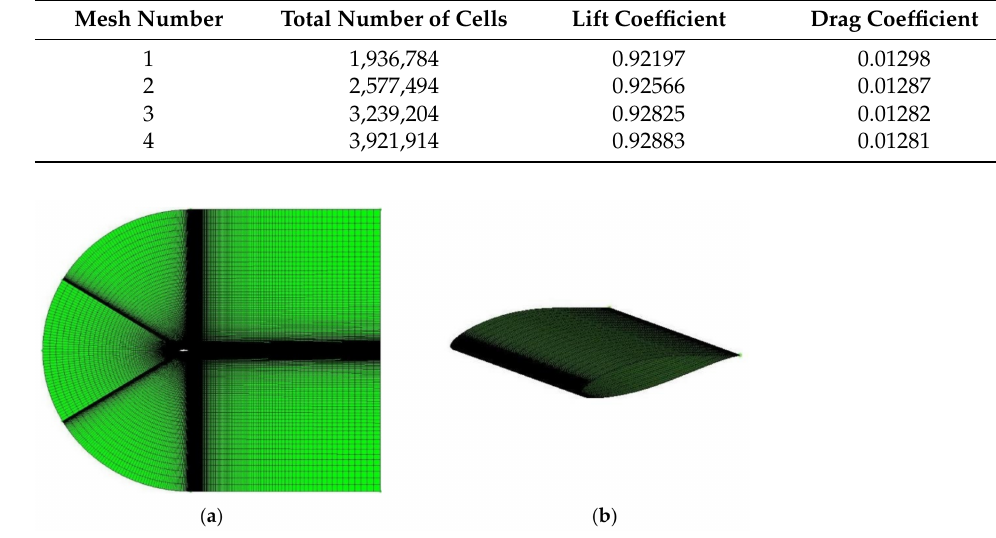
Figure 6. Computational mesh used in the simulation: ( a ) domain volume mesh; ( b ) airfoil surface